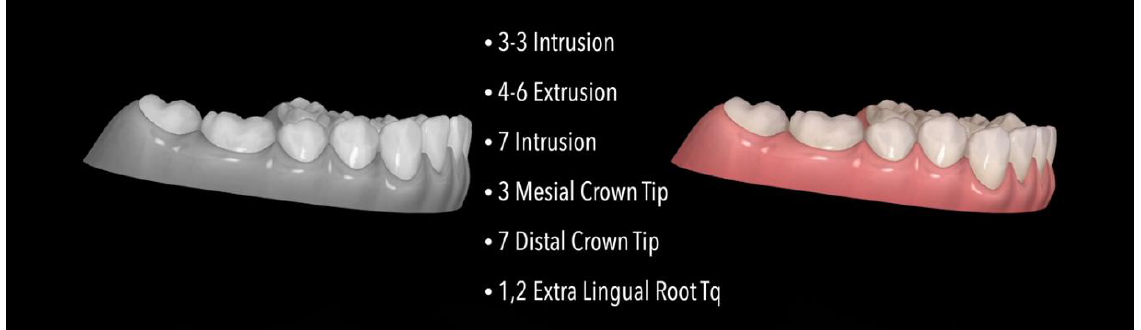
Figure 6. Working setup in a deep bite: ( A ) deep curve of Spee; ( B ) reverse curve of Spee archwire; ( C ) overengineered setup.